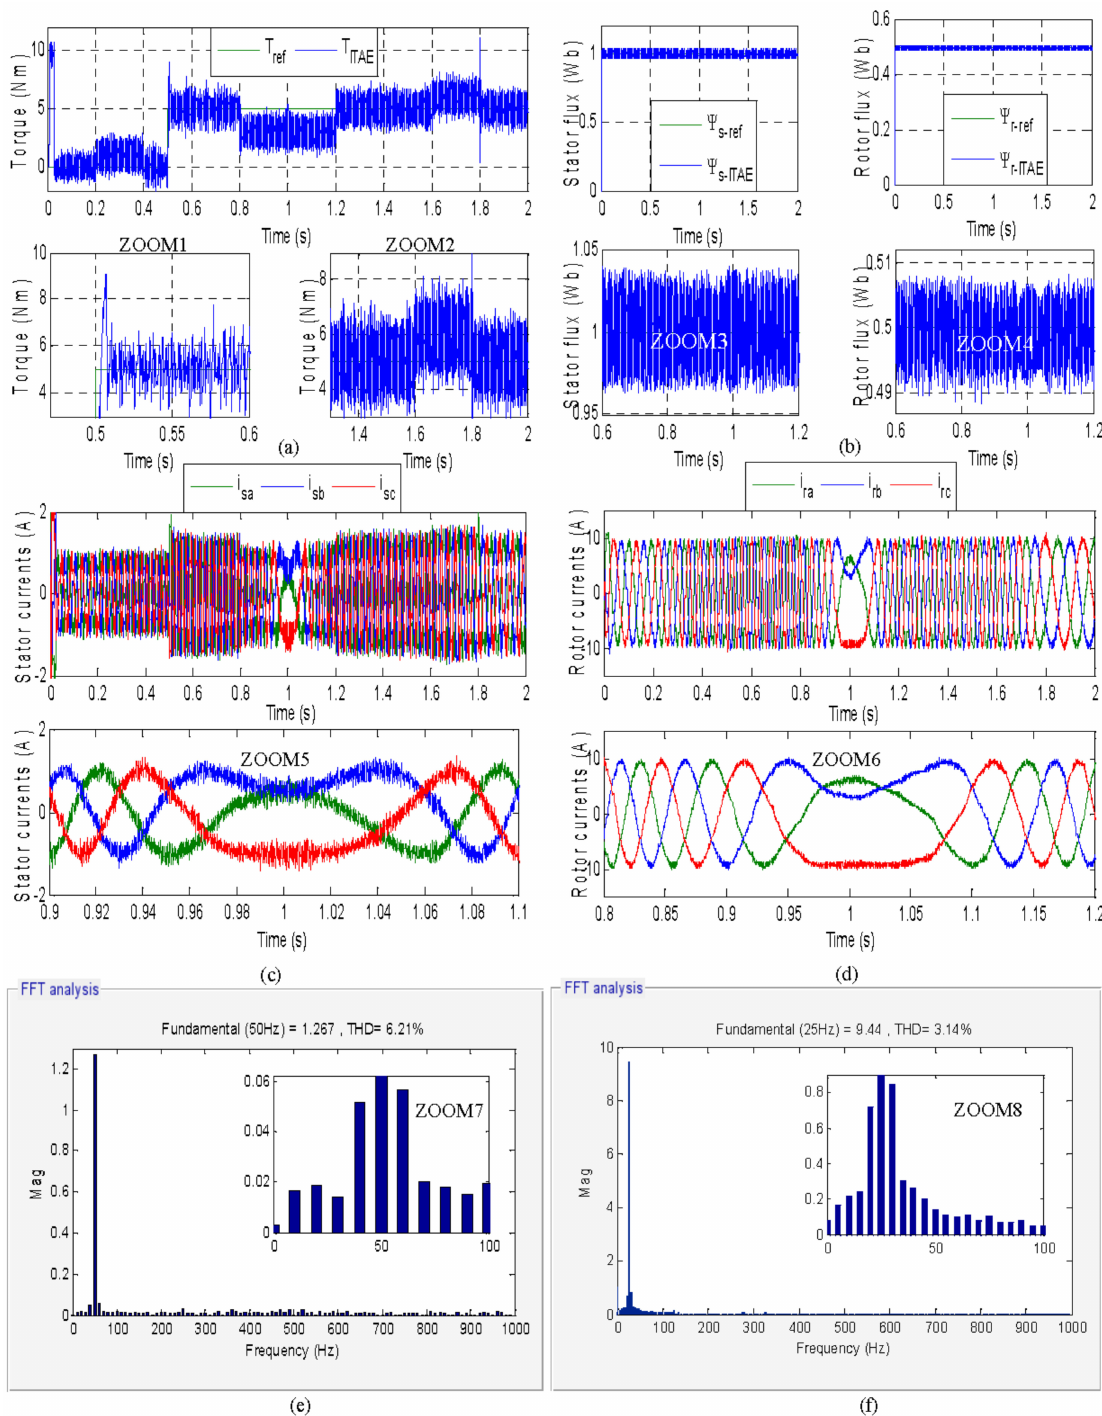
Figure 7. GA-DTC-ITAE performances. ( a ) The electromagnetic torque response. ( b ) The fluxes response. ( c , d ) The stator and rotor currents. ( e , f ) Harmonic spectra of the stator and rotor